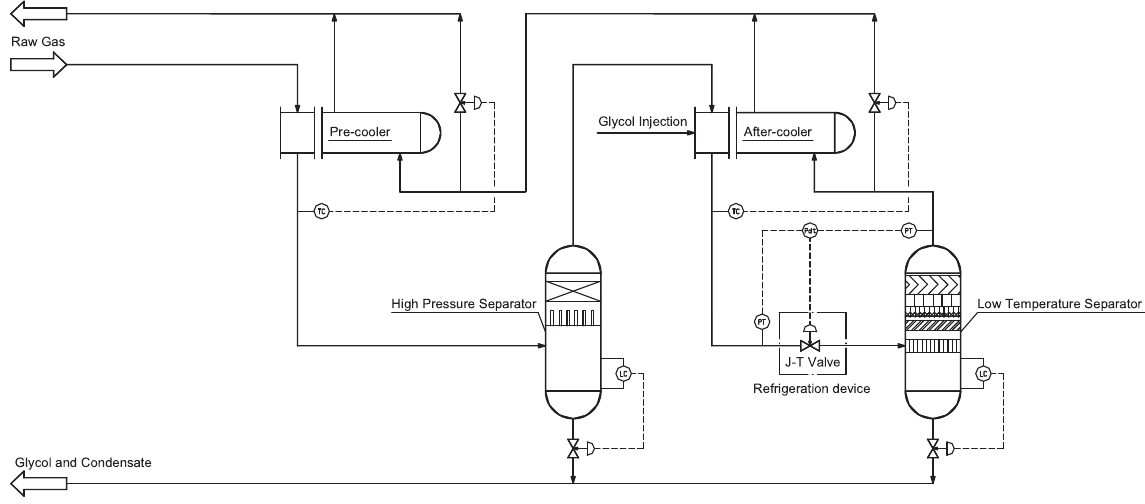
Fig. 1. Conventional Low Temperature Separation (LTS) process fl ow diagram. Note: J-T valve, expander and propane refrigeration system are used as refrigeration device for decrease the natural gas temperature.